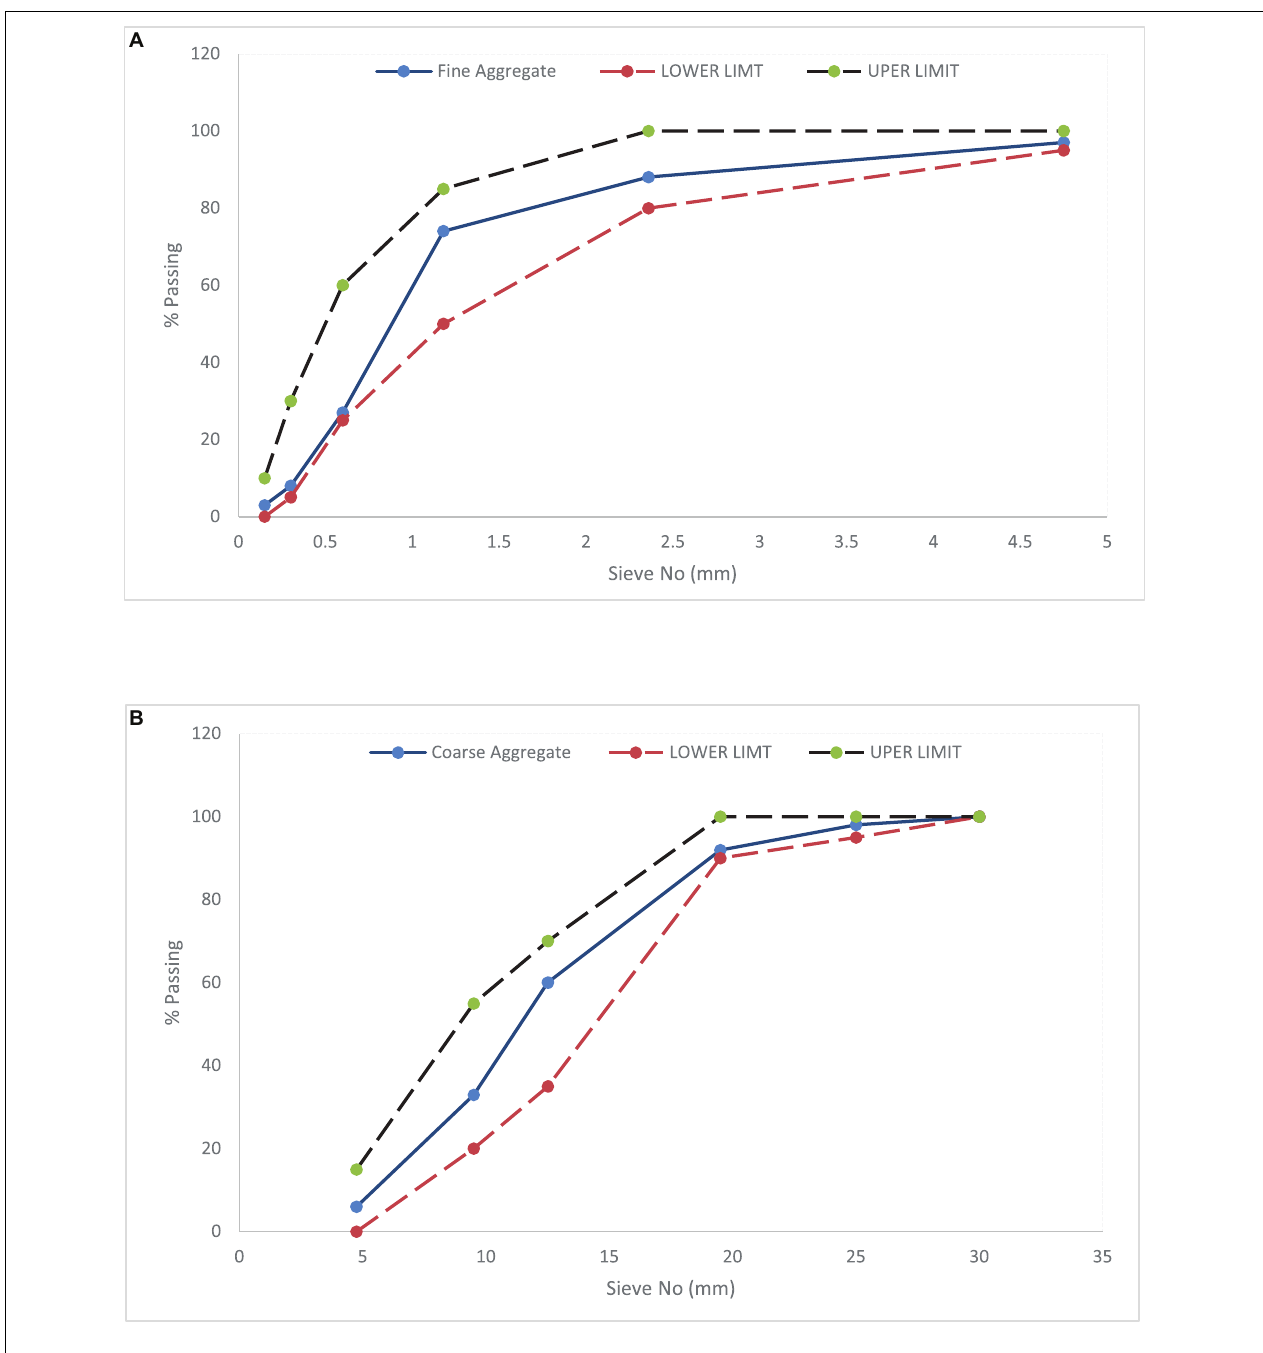
FIGURE 1 | (A) Gradation Curve of Fine Aggregate, (B) Gradation curve of Coarse Aggregate.